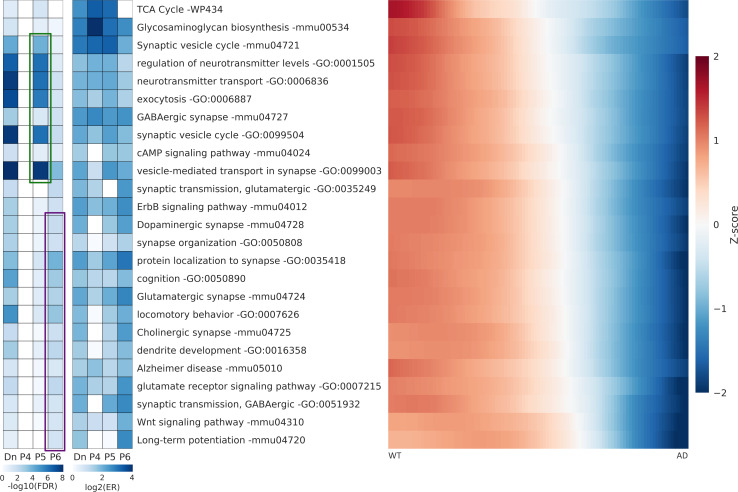
The false discovery rate and enrichment ratio value for downregulated pathways.The false discovery rate (FDR) and enrichment ratio (ER) values for the selected pathways estimated by the gene list of each subset (Down, P4, P5, P6). Each pathway heatmap was estimated by averaging the transition curves of the genes belonging to the Down list. Genes were significantly downregulated for pathways involving the exocytosis of neurotransmitters with lower P5 FDR (the green box) and of specific synaptic functions with lower P6 FDR (the purple box).